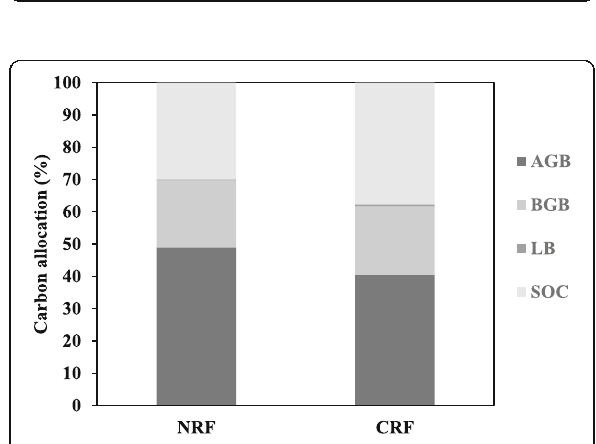
Fig. 2 Contribution of carbon in different pools. AGB aboveground biomass, BGB belowground biomass, LB litter biomass, SOC soil organic